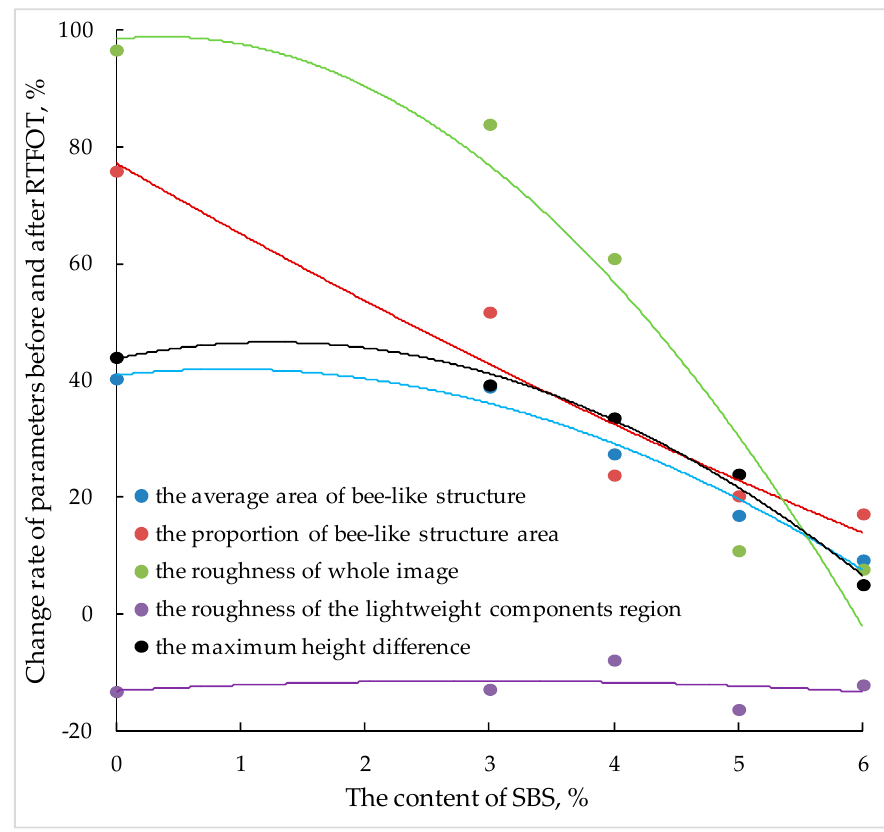
Figure 12. Increase of nano ‐ parameters of SBS modified bitumen after RTFOT.